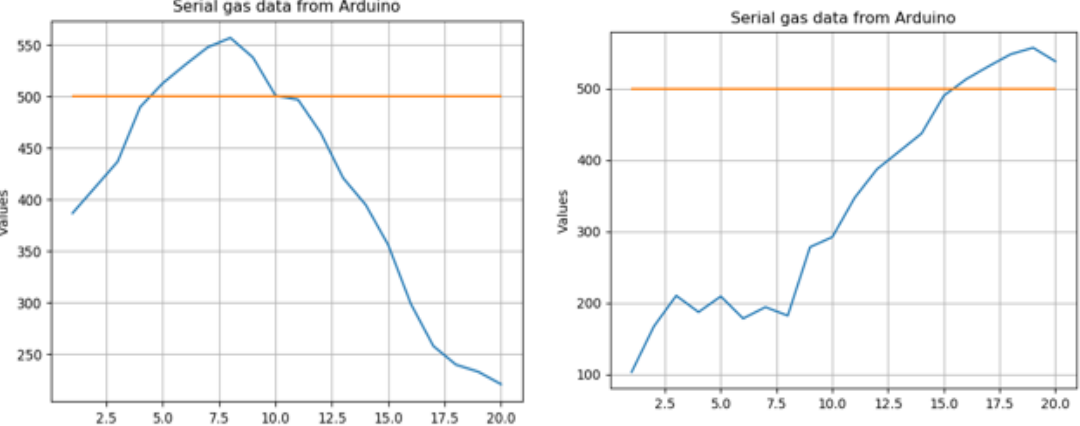
Figure 9. The Car robot passing by a cloth soaked in Acetone (Ox = seconds, Oy = ppm value).